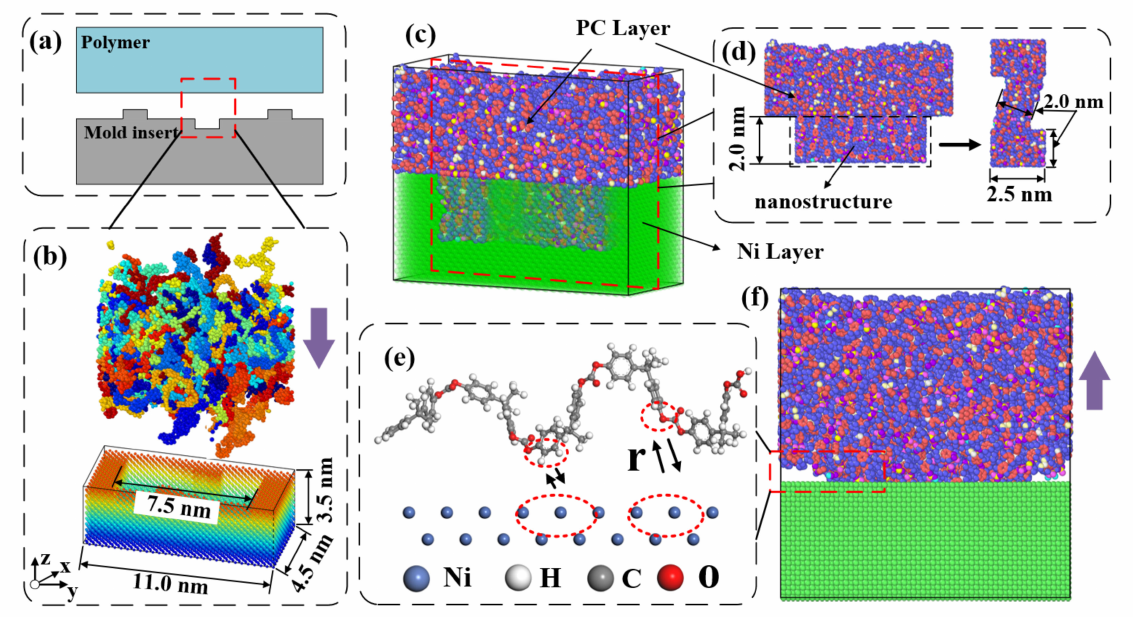
Figure 7. MD model for the injection molding: ( a ) schematic model of filling process, ( b ) initial model of filling process in simulation, ( c ) filling complete model, ( d ) the mixing structure, ( e ) inter- facial interaction between the molecular chains and mold insert atoms in demolding, and ( f ) the demolding